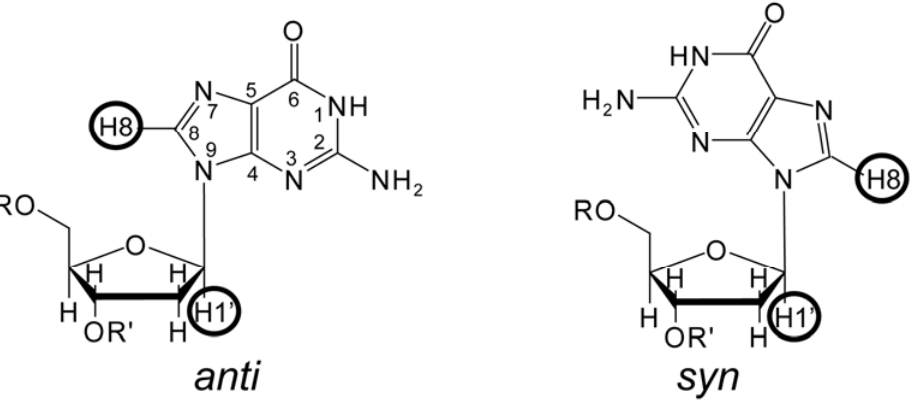
Figure 2. Chemical structures of the syn and anti glycosidic bond angles of